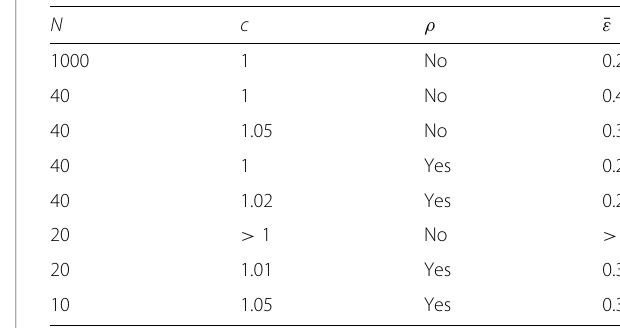
Table 1 Averaged errors ¯ ε for different EnKF